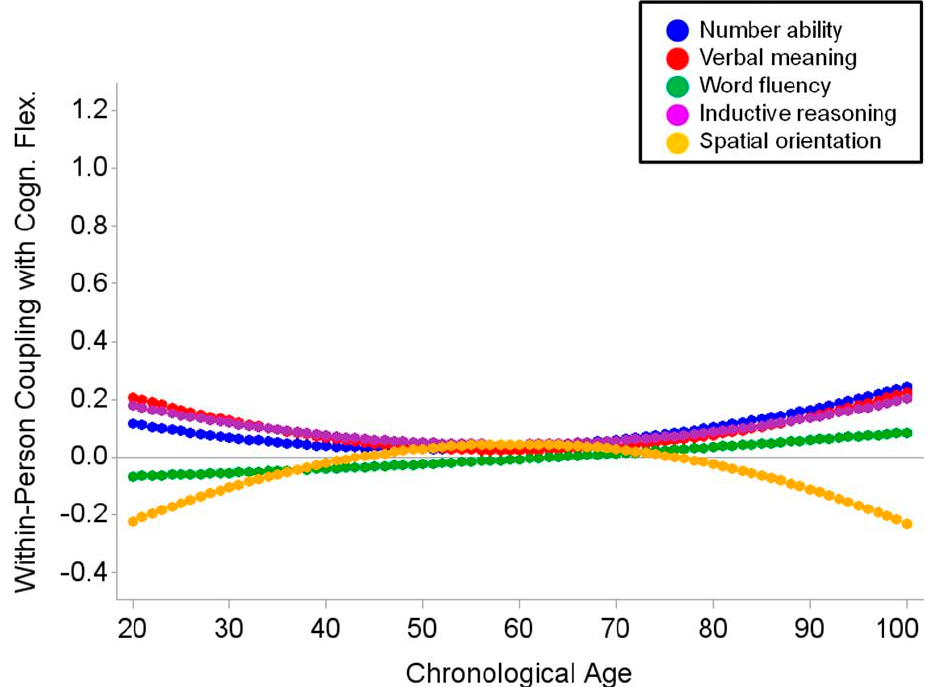
Figure 4. Within-person coupling parameters ( γ 10 ) across chronological age for cognitive flexibility and primary mental abilities. Cognitive flexibility was associated with number ability and inductive reasoning within persons at age 70 years. Linear increase in within-person coupling with cognitive flexibility was observed for number ability, quadratic age trends were observed for verbal meaning and spatial orientation.